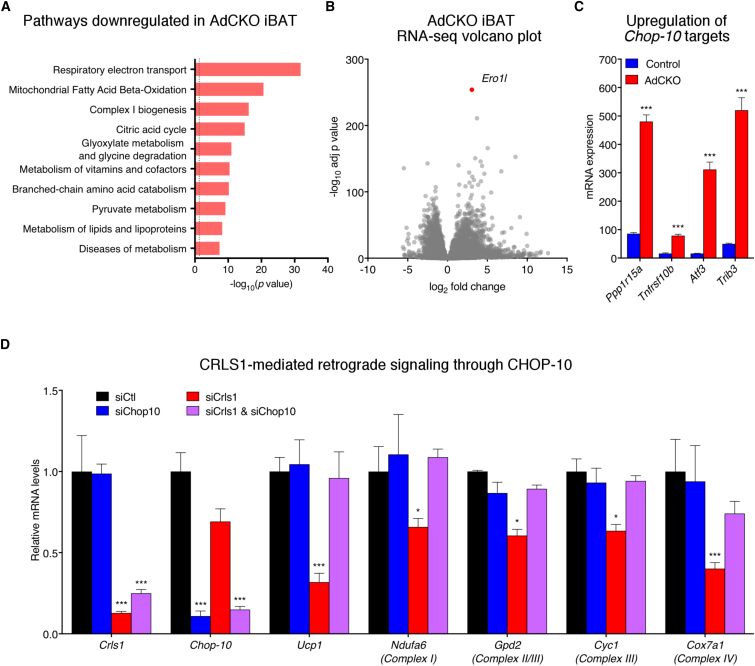
Mitochondrial CL Deficiency Suppresses Nuclear-Encoded Genes through the ER Stress Response Factor CHOP-10(A) Reactome pathways downregulated in AdCKO iBAT compared with control (RNA sequencing [RNA-seq] data; n = 5 per group; housed at 22°C; dashed line indicates adjusted p value <0.05).(B) Volcano plot of RNA-seq data from AdCKO and control iBAT (n = 5 per group).(C) mRNA levels of known CHOP-10 targets from RNA-seq data (n = 5 per group).(D) mRNA levels from brown adipocytes treated with control, Crls1, Chop10, or both Crls1 and Chop10 siRNA. Data are presented as means ± SEM. ∗p < 0.05; ∗∗∗p < 0.001.